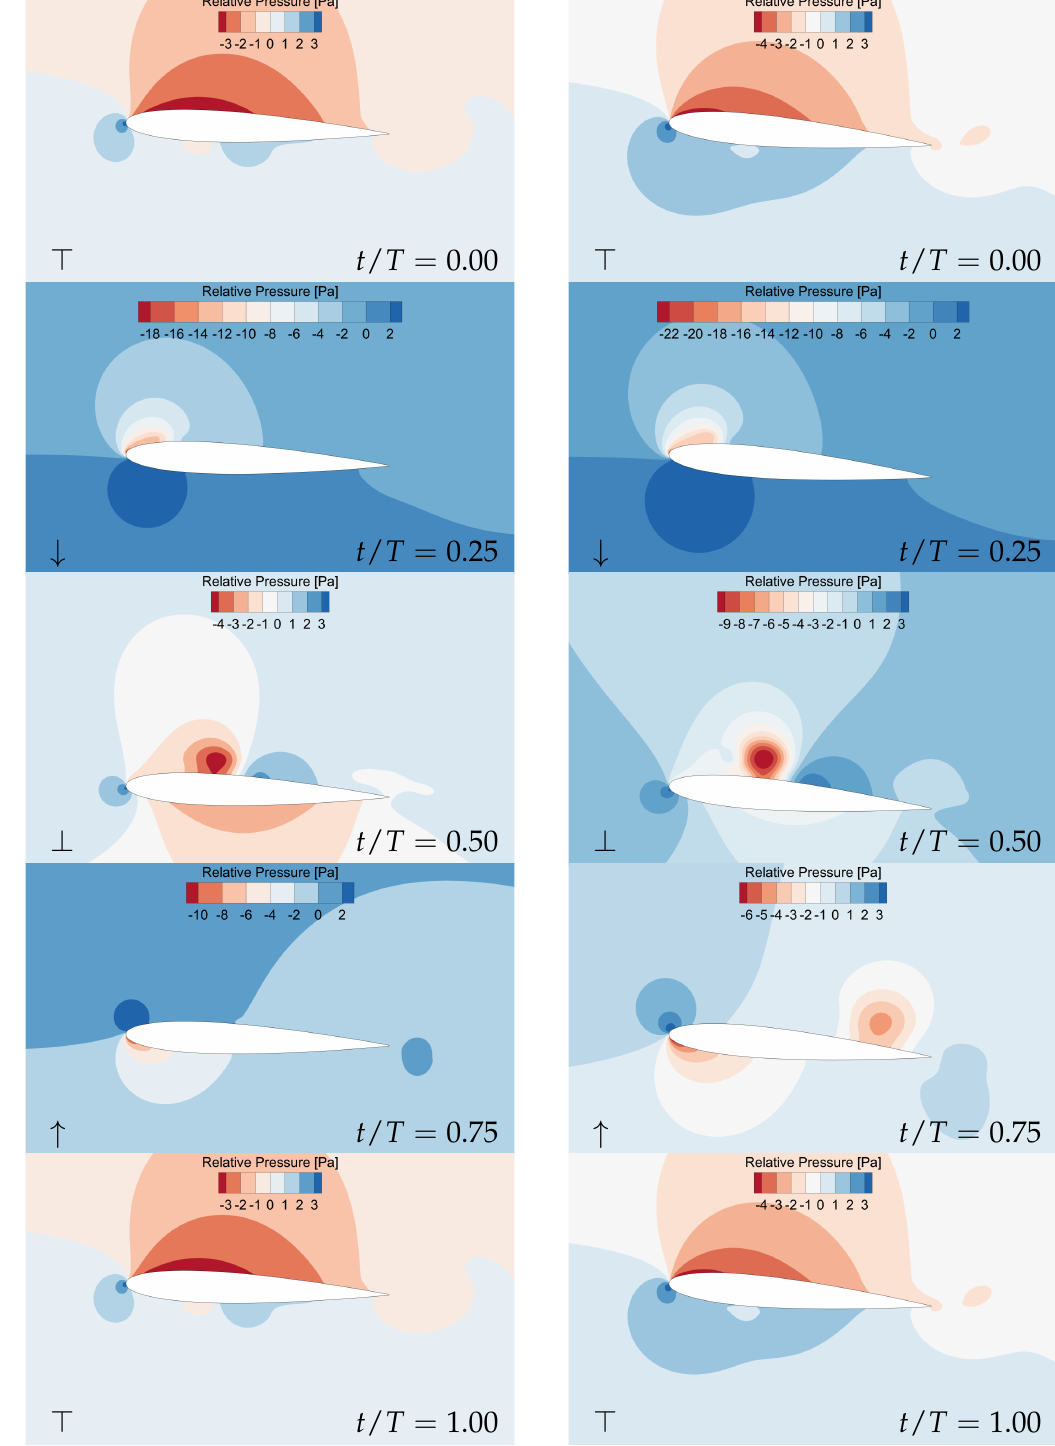
10 4 , k = 2.0 and h = 0.157 with α 0 = 2.5 ◦ (left) and ×